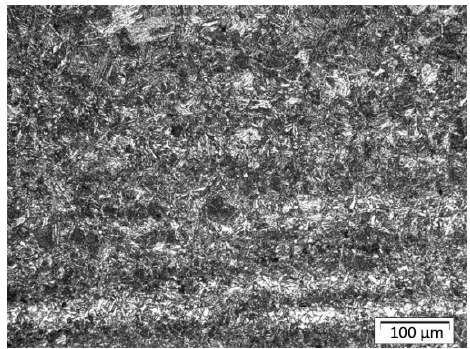
Figure 16. Sample C: the structure of the HAZ in the axis of bead number five.